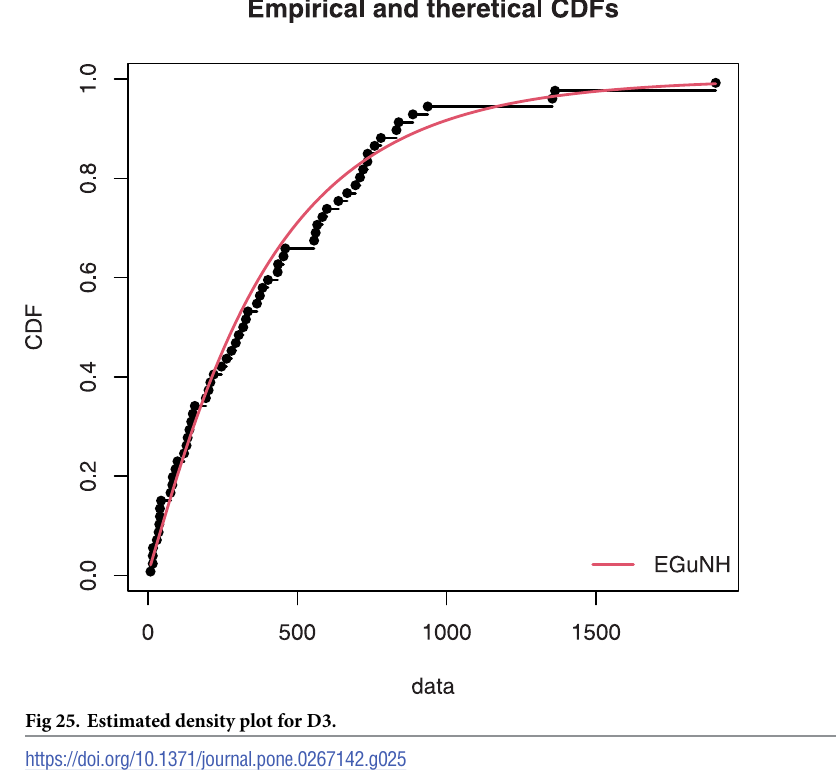
Fig 25. Estimated density plot for D3.